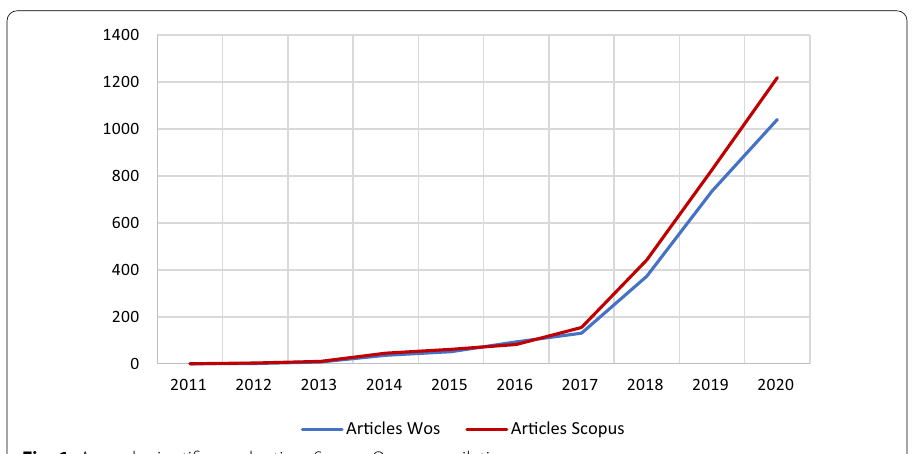
Fig. 1 Annual scientific production. Source : Own